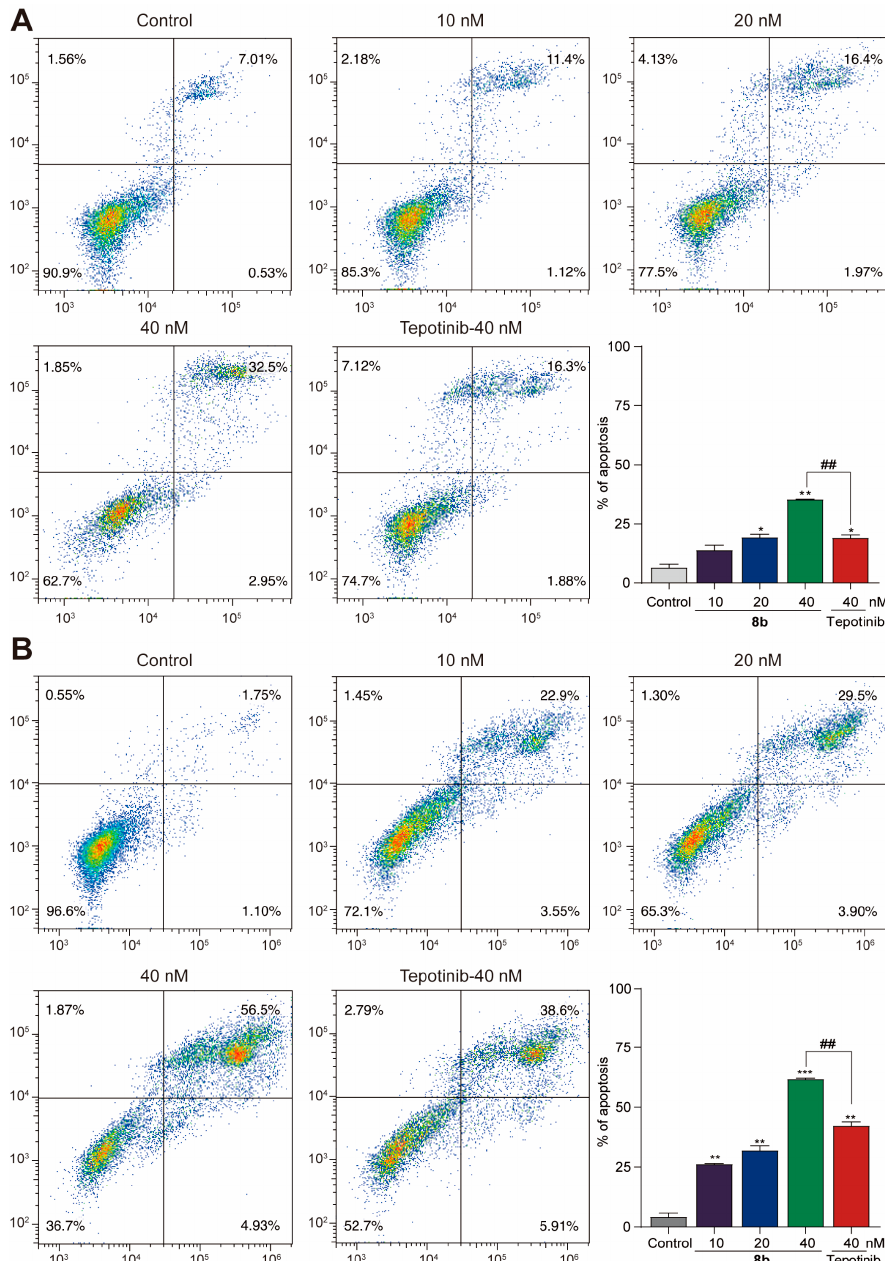
Figure 3. Effect of compound 8b on the apoptosis progression of MHCC97H cells. ( A , B ) Representative flow cytometric profiles showing that compound 8b (10, 20 and 40 nM) induced the apoptosis of MHCC97H cells after 24 and 48 h, respectively. Histograms show the proportions of apoptotic cells. * p < 0.05, ** p < 0.01, *** p < 0.001 vs . control group; ## p < 0.01, compound 8b (40 nM) vs. tepotinib 7 (40 nM).